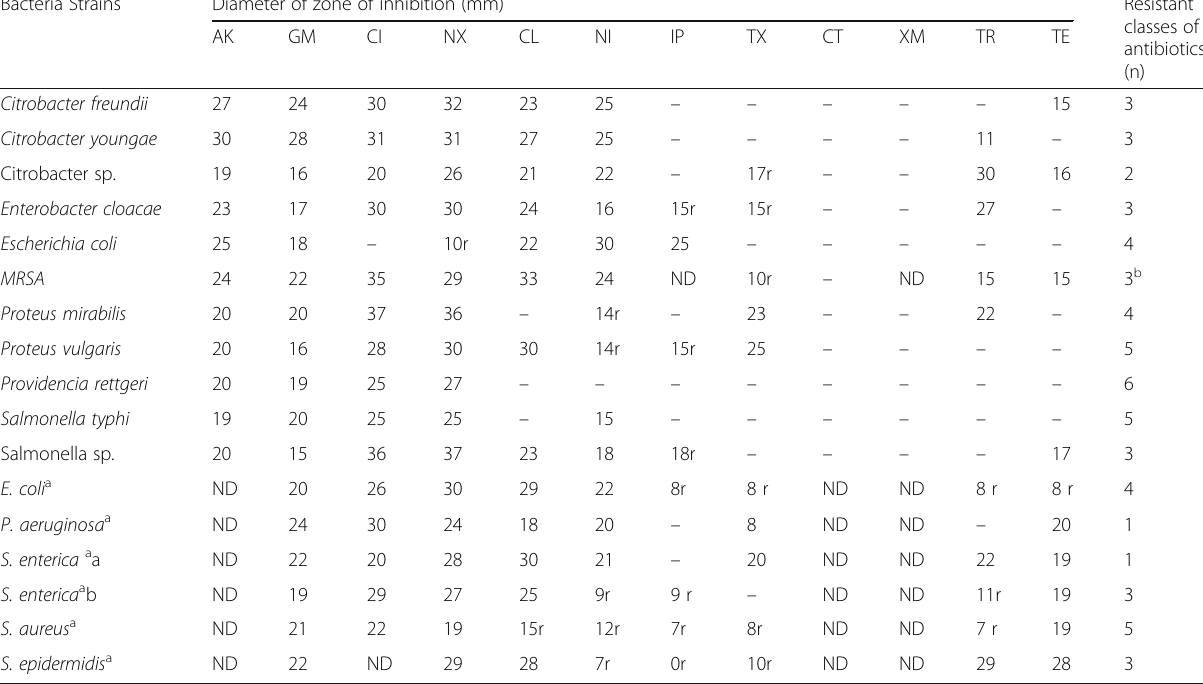
Table 2 Susceptibility of bacterial strains to standard antibiotics Bacteria Strains